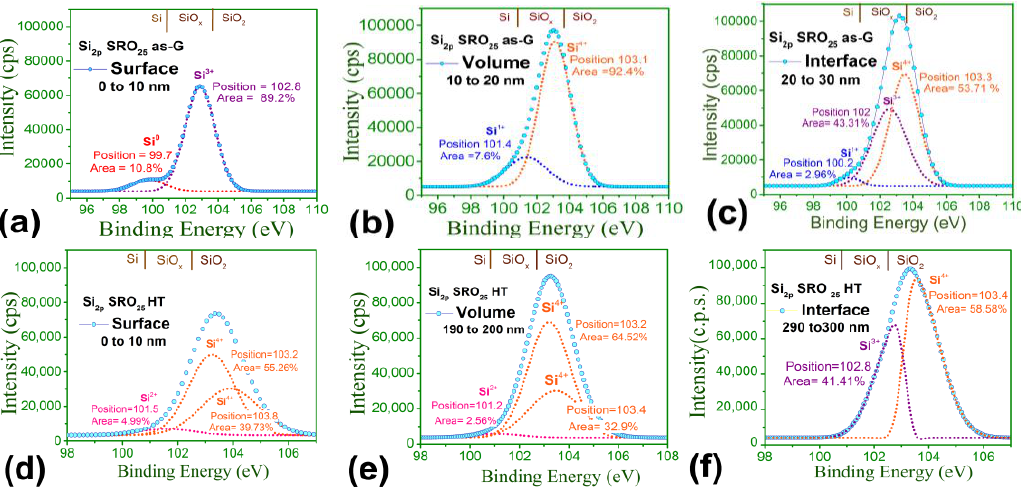
Figure 2. XPS spectra of Si 2p of single-layer films of SRO 25 ( a ), ( b ) and ( c ) as-G and ( d ), ( e ) and ( f ) with HT, with different oxidation states on the surface, in the volume, and at the SRO/Si interface.